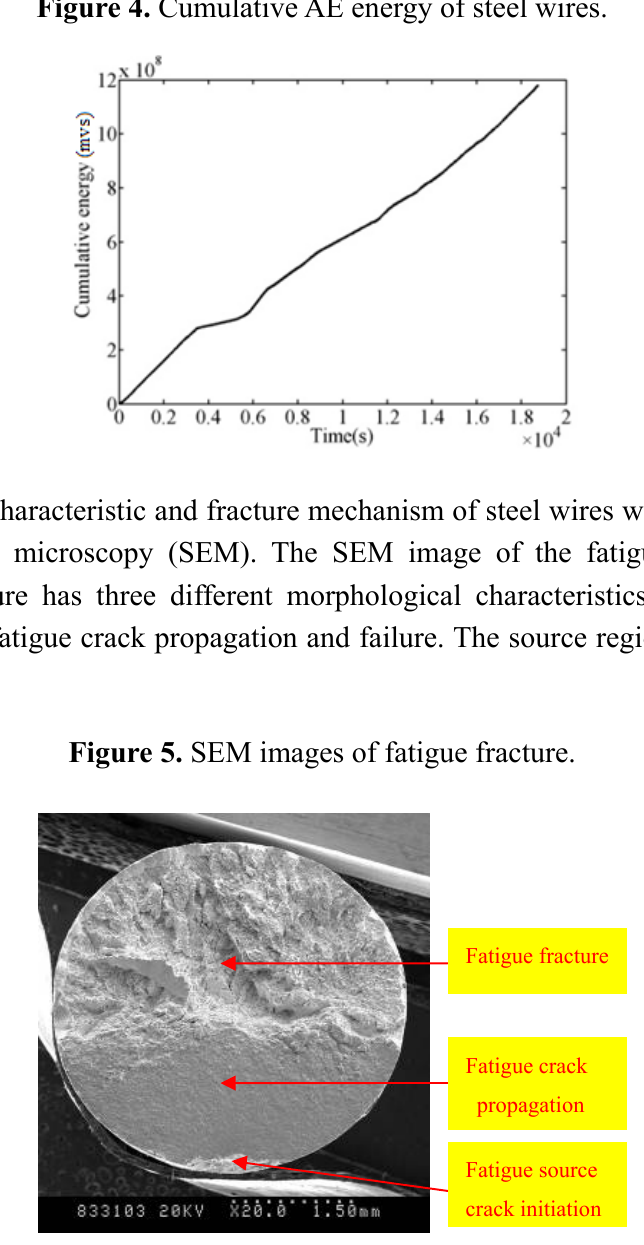
Figure 4. Cumulative AE energy of steel wires.